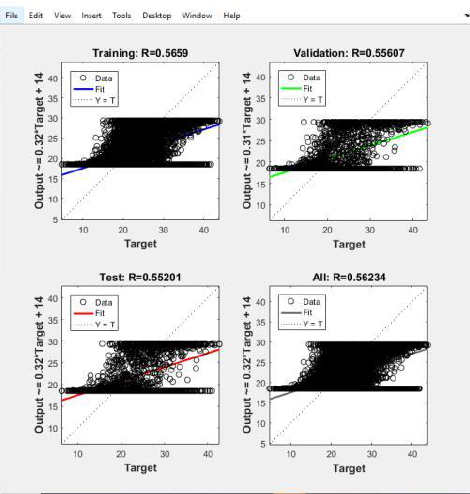
Figure 9 . The three plots represent the training, validation, and testing data. The dashed line in each plot represents the perfect result – outputs = targets. The solid line represents the best fit linear regression line between outputs and targets. The R value is an indication of the relationship between the outputs and targets. If R = 1, this indicates that there is an exact linear relationship between outputs and targets. If R is close to zero, then there is no linear relationship between outputs and targets.